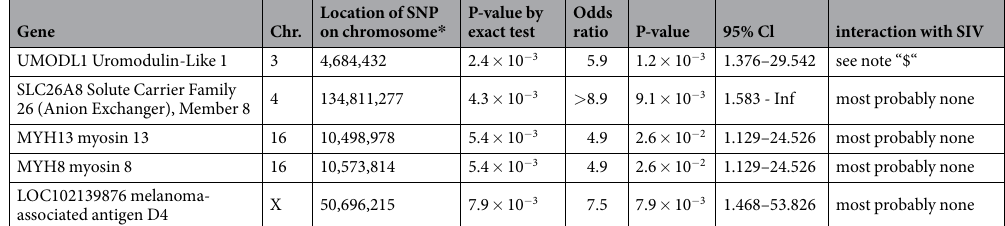
P-value by exact test